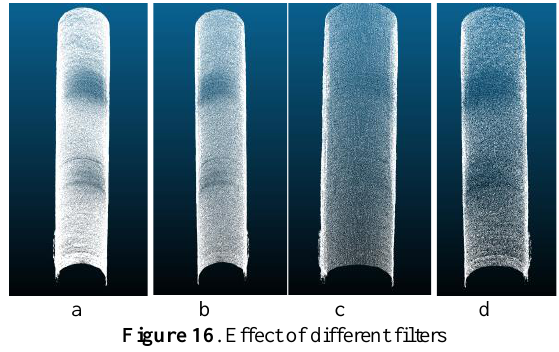
Figure 16 . Effect of different filters